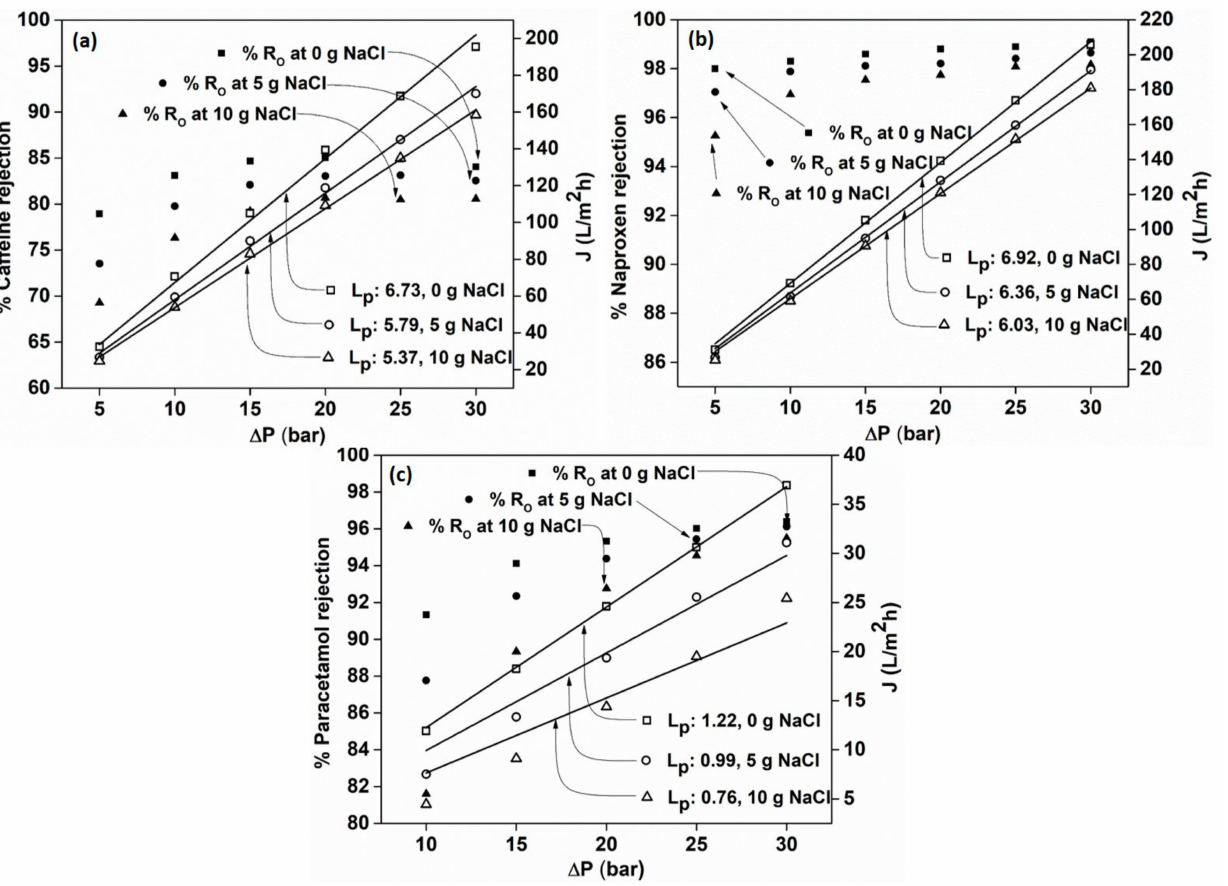
Figure 6. Effect of ionic strength on the rejection efficiency of ( a ) caffeine, ( b ) naproxen and ( c )